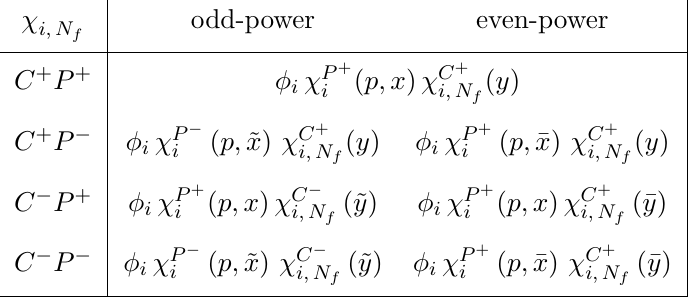
and χ C,P branch in terms of group i,N f , even-power i,N f , odd-power and χ C ± i i,N f